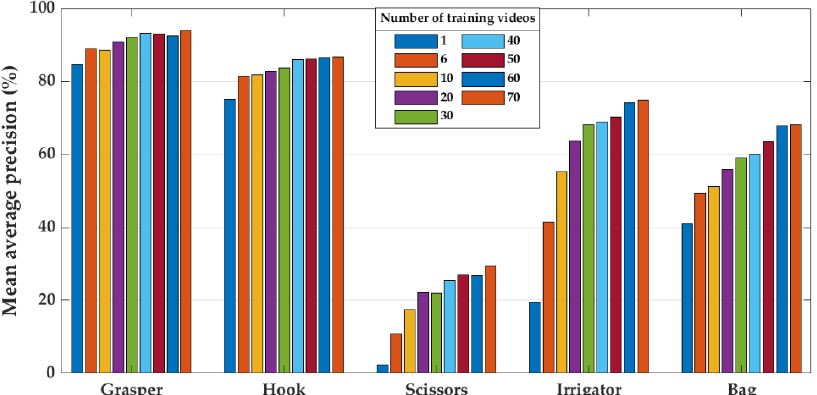
Figure 9. Mean average precision on the tools in the last ten videos of the Cholec80, EndovisChole and Gyna08 datasets as a function of training set size.